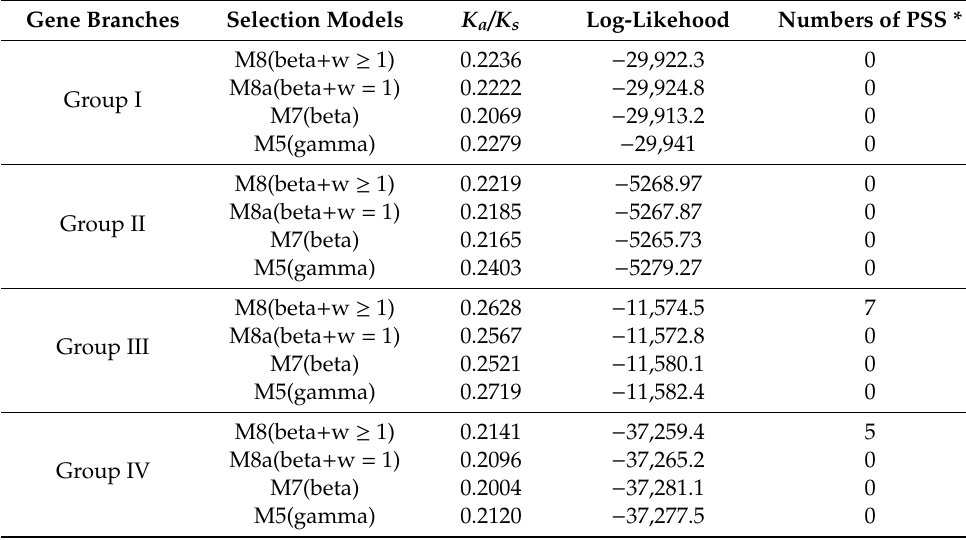
Table 2. Likelihood values and parameter estimates of the Aqp